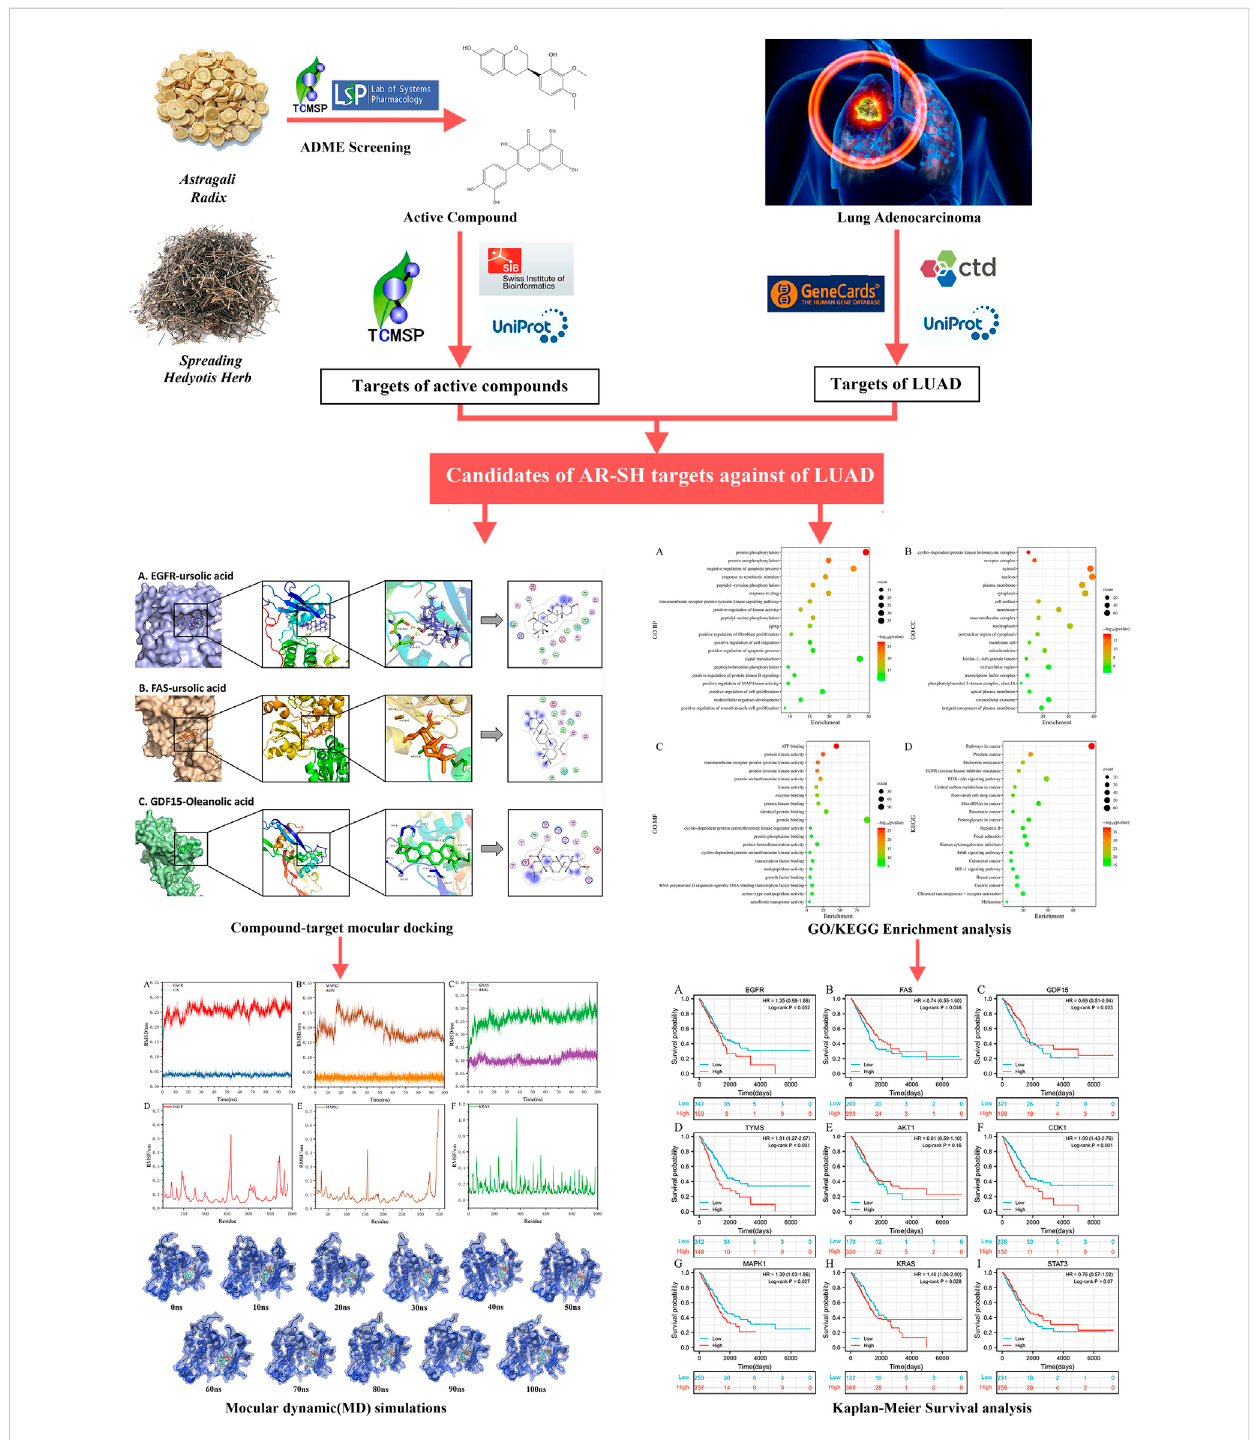
FIGURE 1 Flow chart of the employed systemic pharmacology